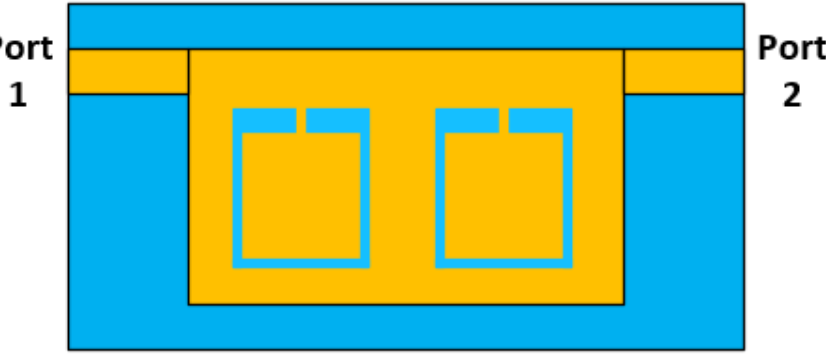
Figure 10. Procedure of the microfluidic channel mold filled with PDMS solution.